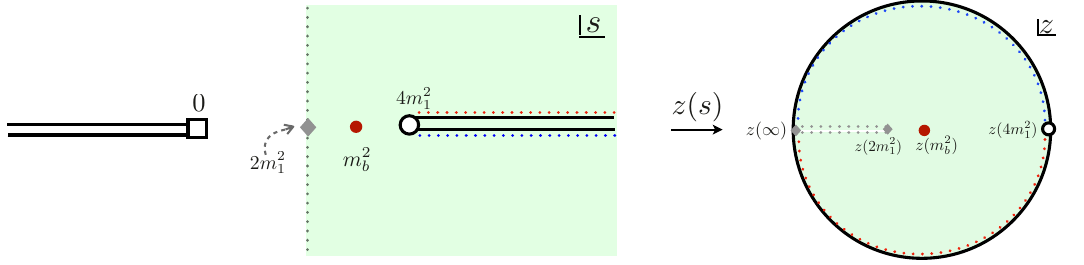
Figure 21. The change of variables from s to z trivialises the crossing symmetry of the S-matrix and maps the cut half-plane s > 2 m 2 the boundary of the unit disk. In doing so, it maps s = m 2